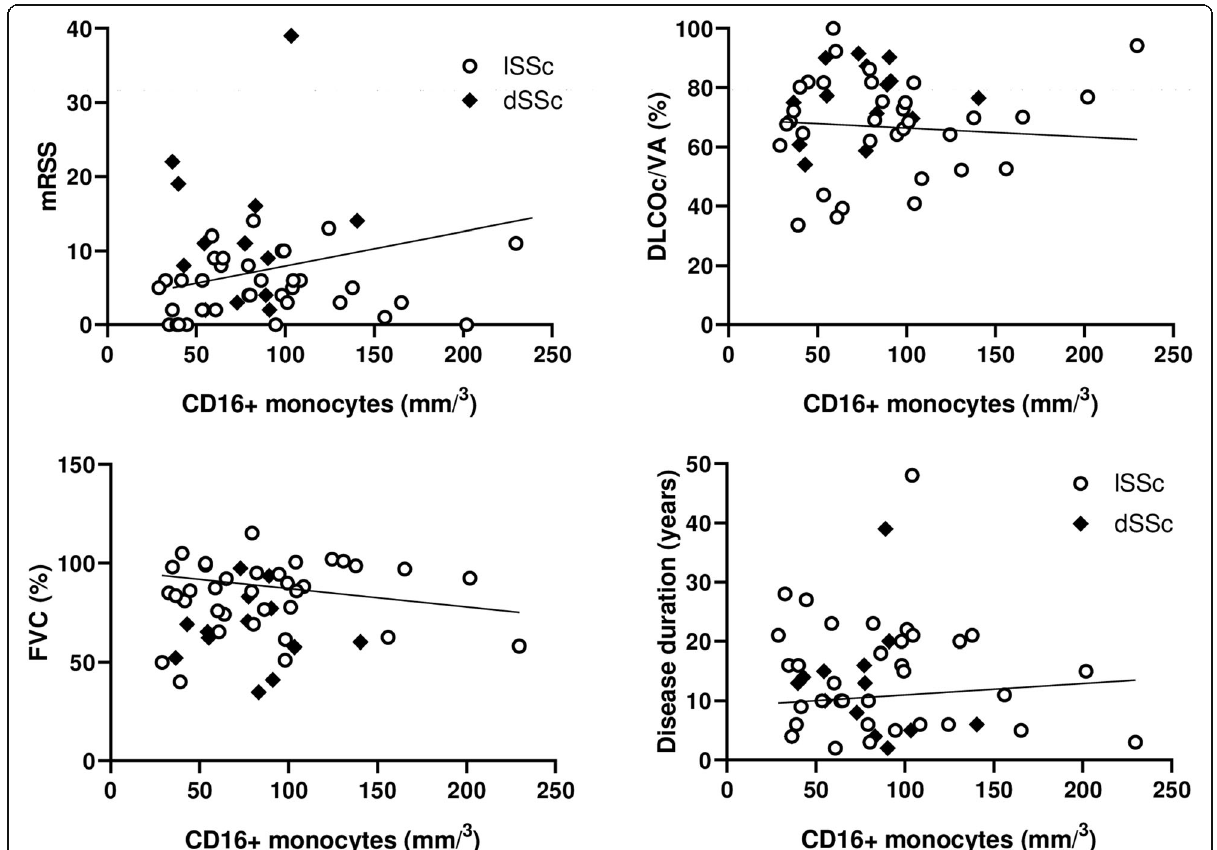
Fig. 3 Correlations regarding the CD16+ monocyte subpopulation. The CD16+ monocyte subpopulation of SSc patients ( n = 50) and in the subgroup of patients presenting lSSc ( n = 36) and dSSc ( n = 14) was tested for association with cutaneous fibrosis assessed by the modified Rodnan skin score (mRSS), pulmonary involvement assessed by DLCOc/VA and FVC. Disease duration was not associated with CD16 + values. DLCO: diffusion capacity for carbon monoxide; FVC: forced vital